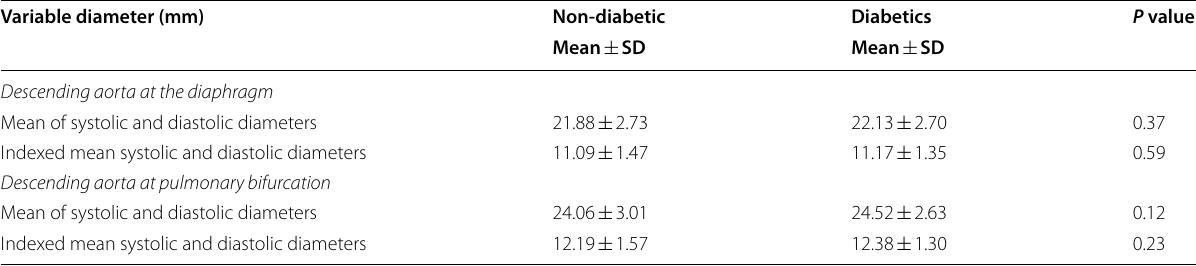
Table 20 Comparison of descending thoracic aorta diameters in diabetic and non‑diabetic groups Variable diameter (mm)